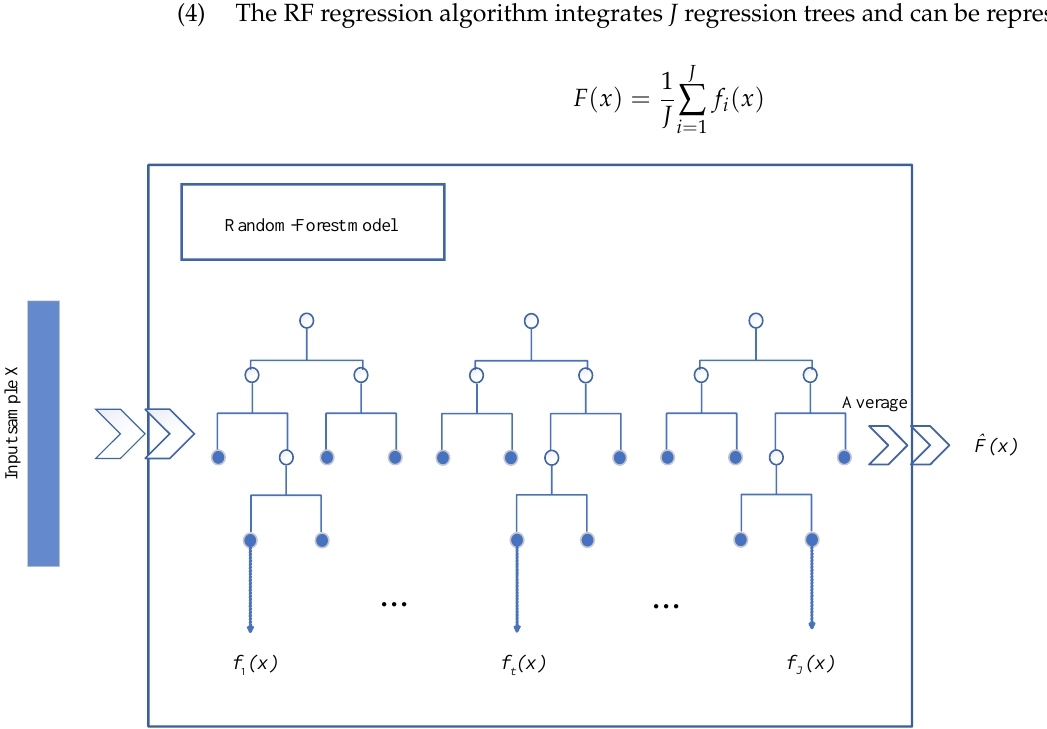
Figure 2. Diagram of random forest process.